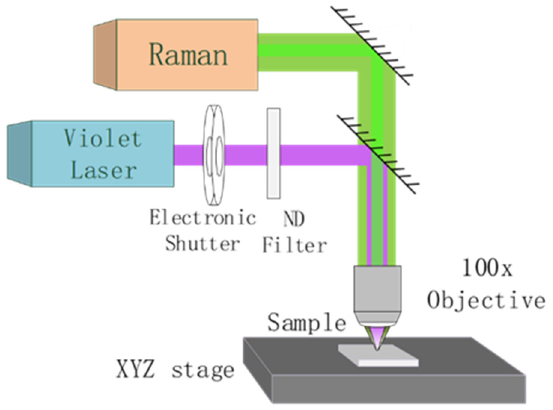
Figure 2. The optical scheme of laser-induced thermal annealing and the polarized micro Raman system. ND Filter: neutral density